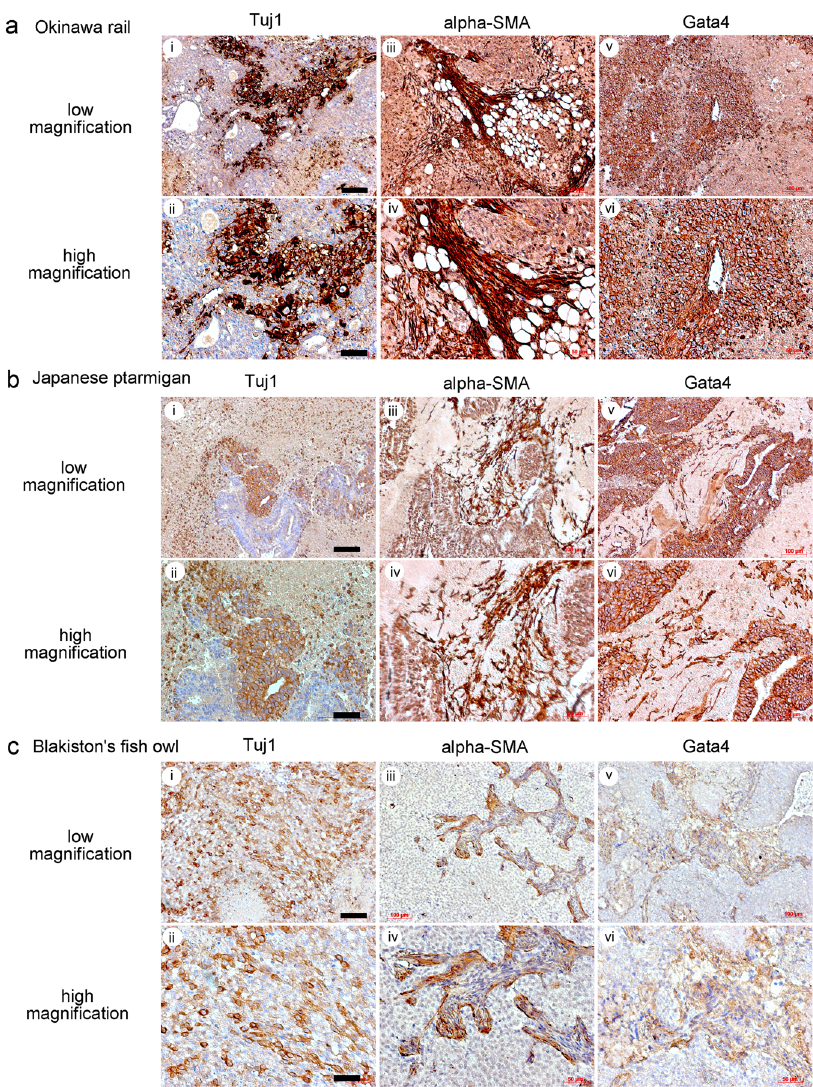
Fig. 7 Histological analysis with immunological staining of Okinawa rail, Japanese ptarmigan, and Blakiston ’ s fi sh owl iPSCs derived teratomas. Histological analysis with Tuj1, alpha-smooth muscle (SMA), Gata4 antibody. Immunological staining of Okinawa rail ( a ), Japanese ptarmigan ( b ), and Blakiston fi sh owl ( c ) iPSC-derived teratomas. Those panels shows low magni fi cation (i, iii, v) and high magni fi cation (ii, iv, vi). Histological analysis with Tuj1 antibody (i, ii), histological analysis with alpha-smooth muscle (SMA) antibody (iii, iv), histological analysis with Gata4 antibody (v, vi). Bars indicate 100 μ m (i, iii, v) or 50 μ m (ii, iv,